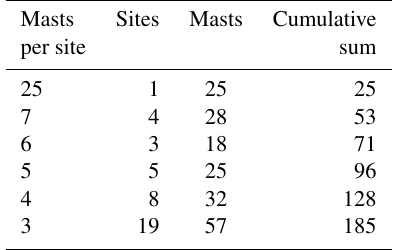
Table 1. Number of met masts used for the study. Masts